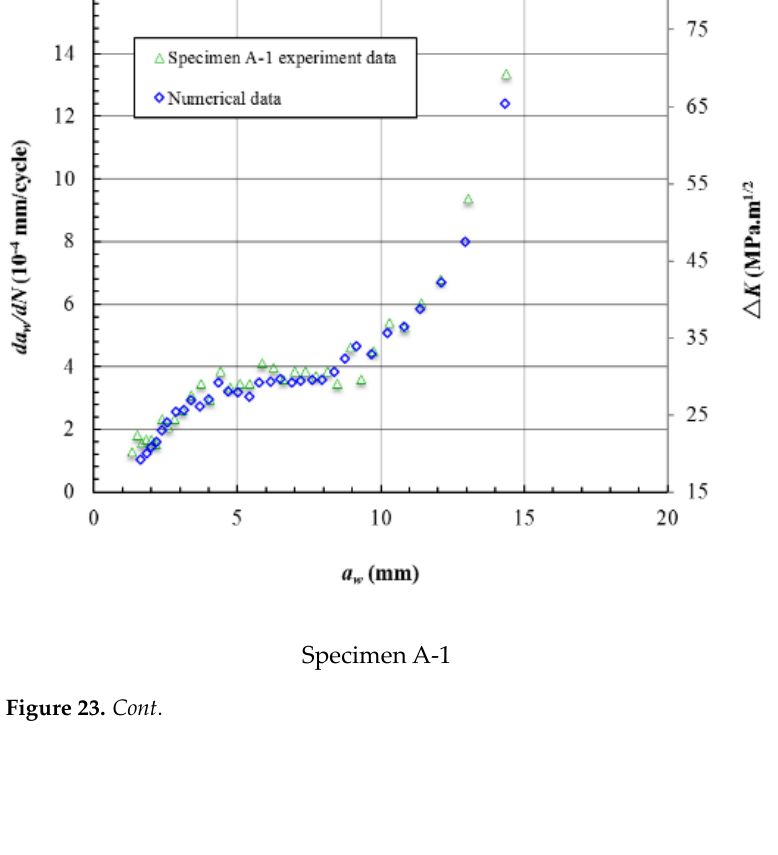
Figure 22. The stress intensity factor distribution at each crack front. The Δ K was calculated based on the R = 0.1 and the K max . Figure 23 gives the crack growth rate and Δ K varying with the crack length a w , and the Δ K data plotted on the sec- ondary axis. The bounds of the axis can affect the shape of the data line but the trend will not be affected. Figure 23 shows that the crack growth rate data almost coincide with the Δ K data. This means that the crack growth rate is mainly affected by the stress intensity factor at the crack front. Figure 24 shows the crack growth rate and Δ K varying with the crack length a t , and the trends are also coincident.